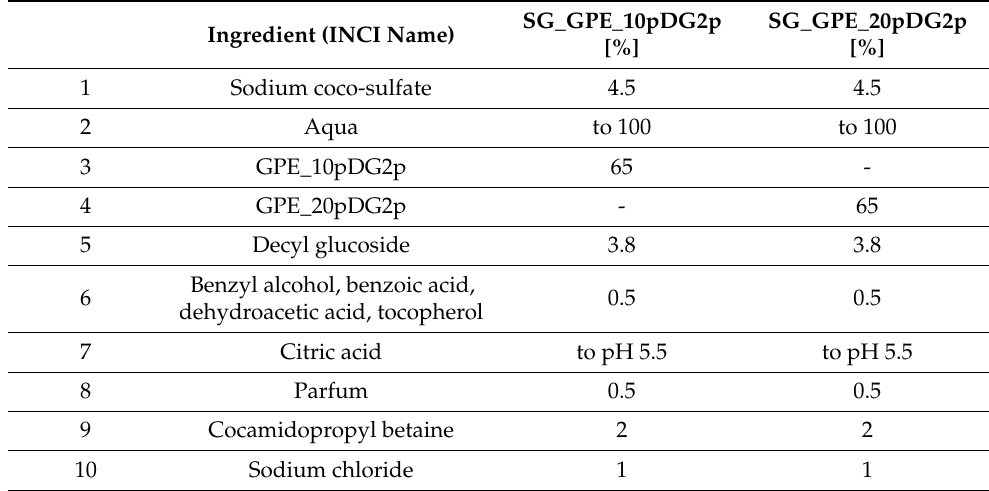
Table 8. Formulation of a model cosmetic (shower